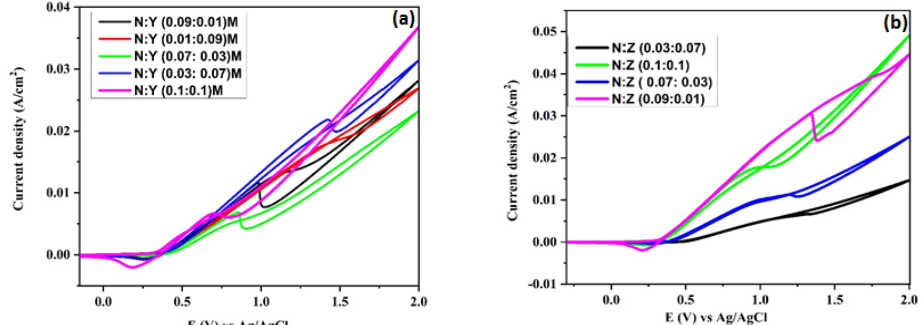
Figure 5. Cyclic voltammogram of ( a ) NiO-Y 2 O 3 /FTO ( b ) NiO-ZrO 2 /FTO thin films deposited from precursor solutions with different Ni: Y and Ni: Zr concentrations. Table 4. Current density values of different Ni: Y concentration thin films at the specified Table 5. Current density values of different Ni: Zr concentration thin films at the specified potential. Ni:Zr